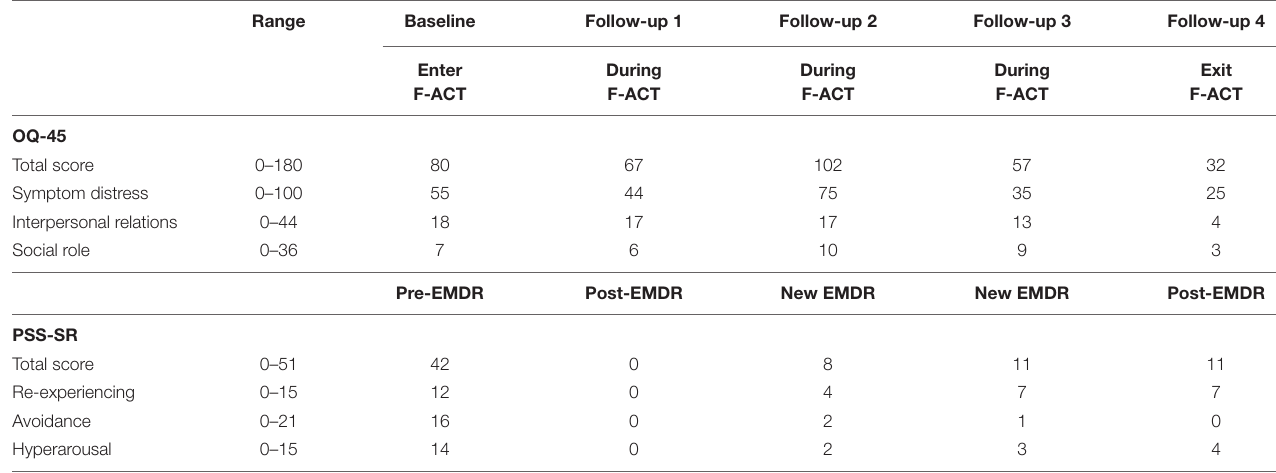
TABLE 4 | Overview of baseline and follow − up